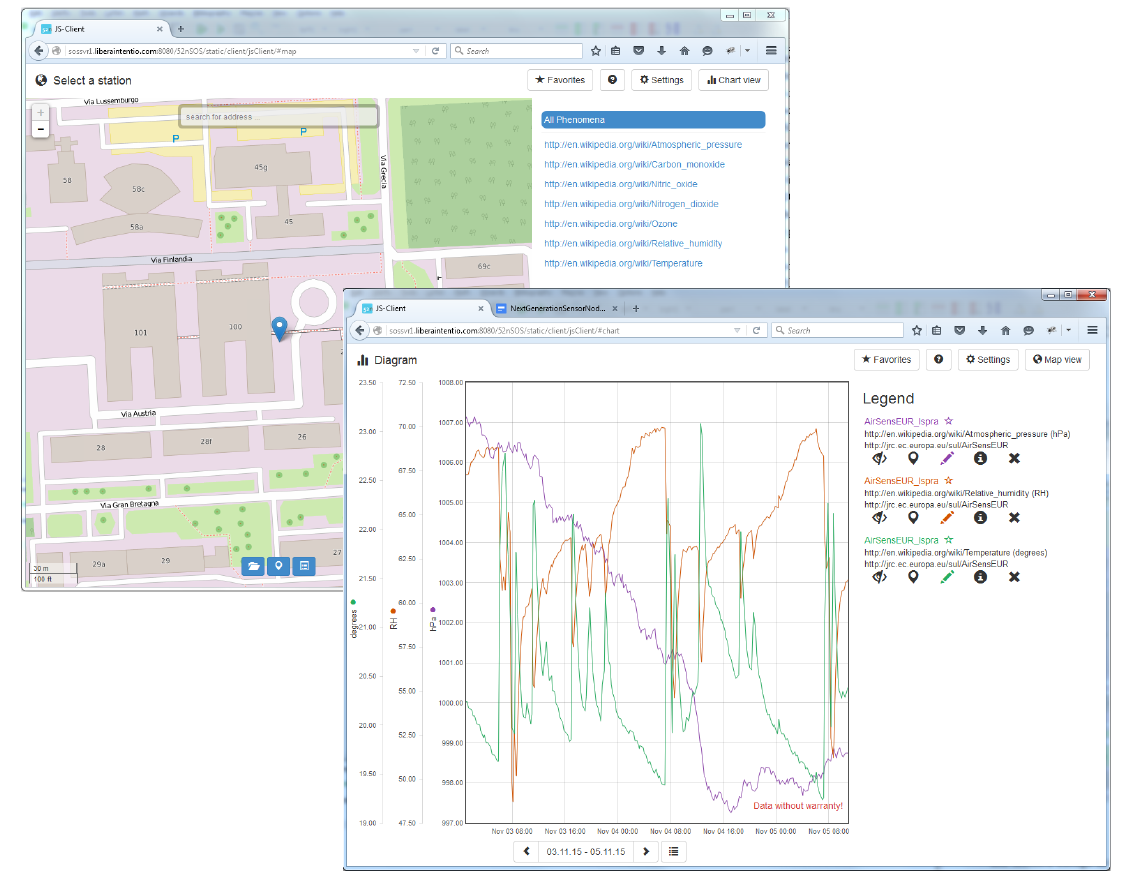
Figure 5. User interface of the 52 ◦ North SensorWeb client, loaded with AirSensEUR data.